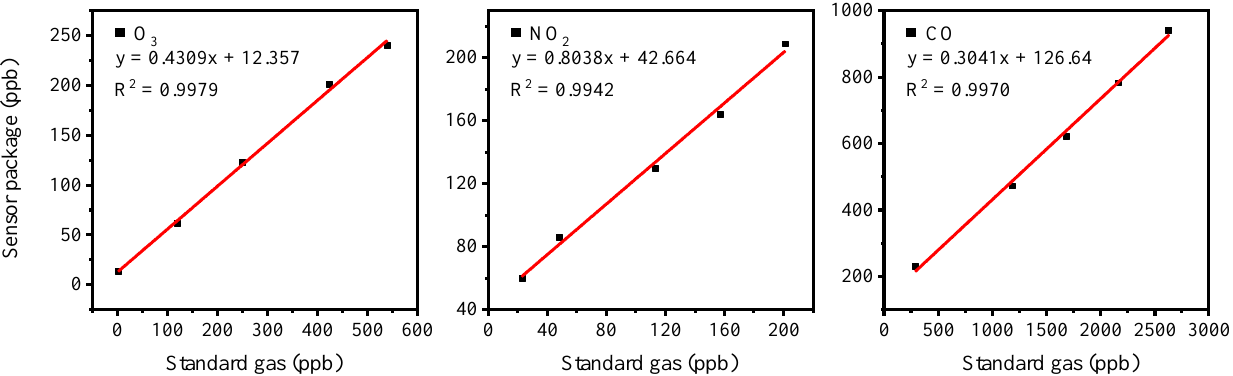
Figure 3. Calibration curves of the sensor package responses to the standard gases at different concentrations with their linear correlation coefficients (R 2 ): 0.9979 for O 3 , 0.9942 for NO 2 and 0.9970 for CO.